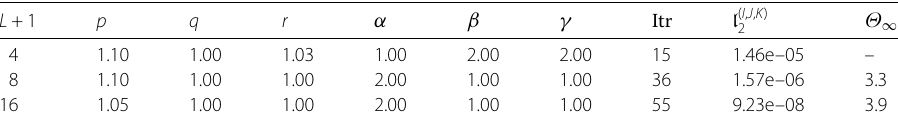
Table 4c Errors and computational rate for the EF-EEG-TOCS in Example 5.4 L +